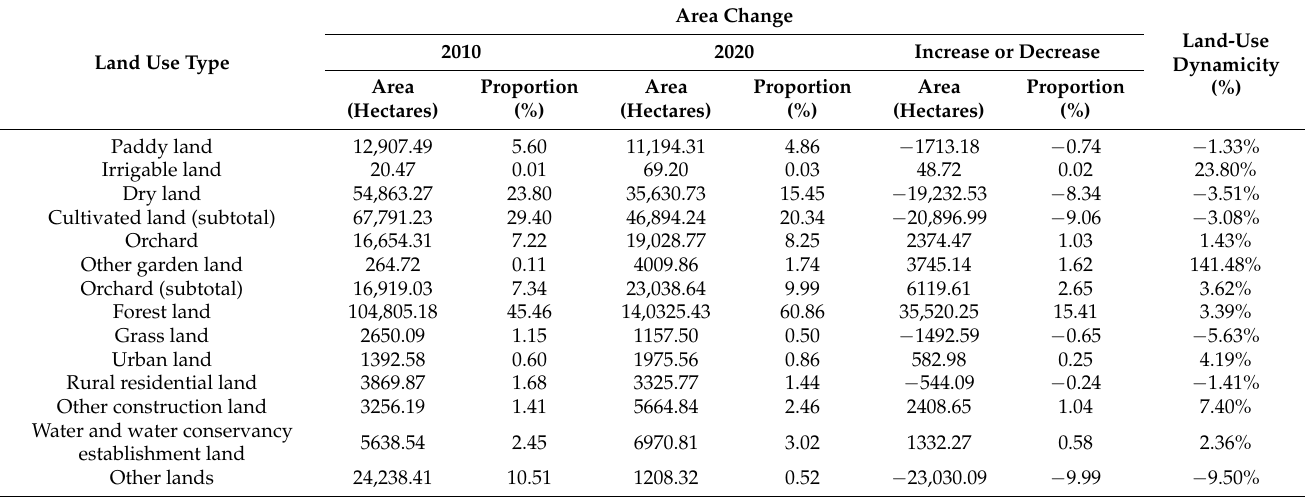
Table 3. Land-use quantity changes and land-use dynamicity in Long’an County,